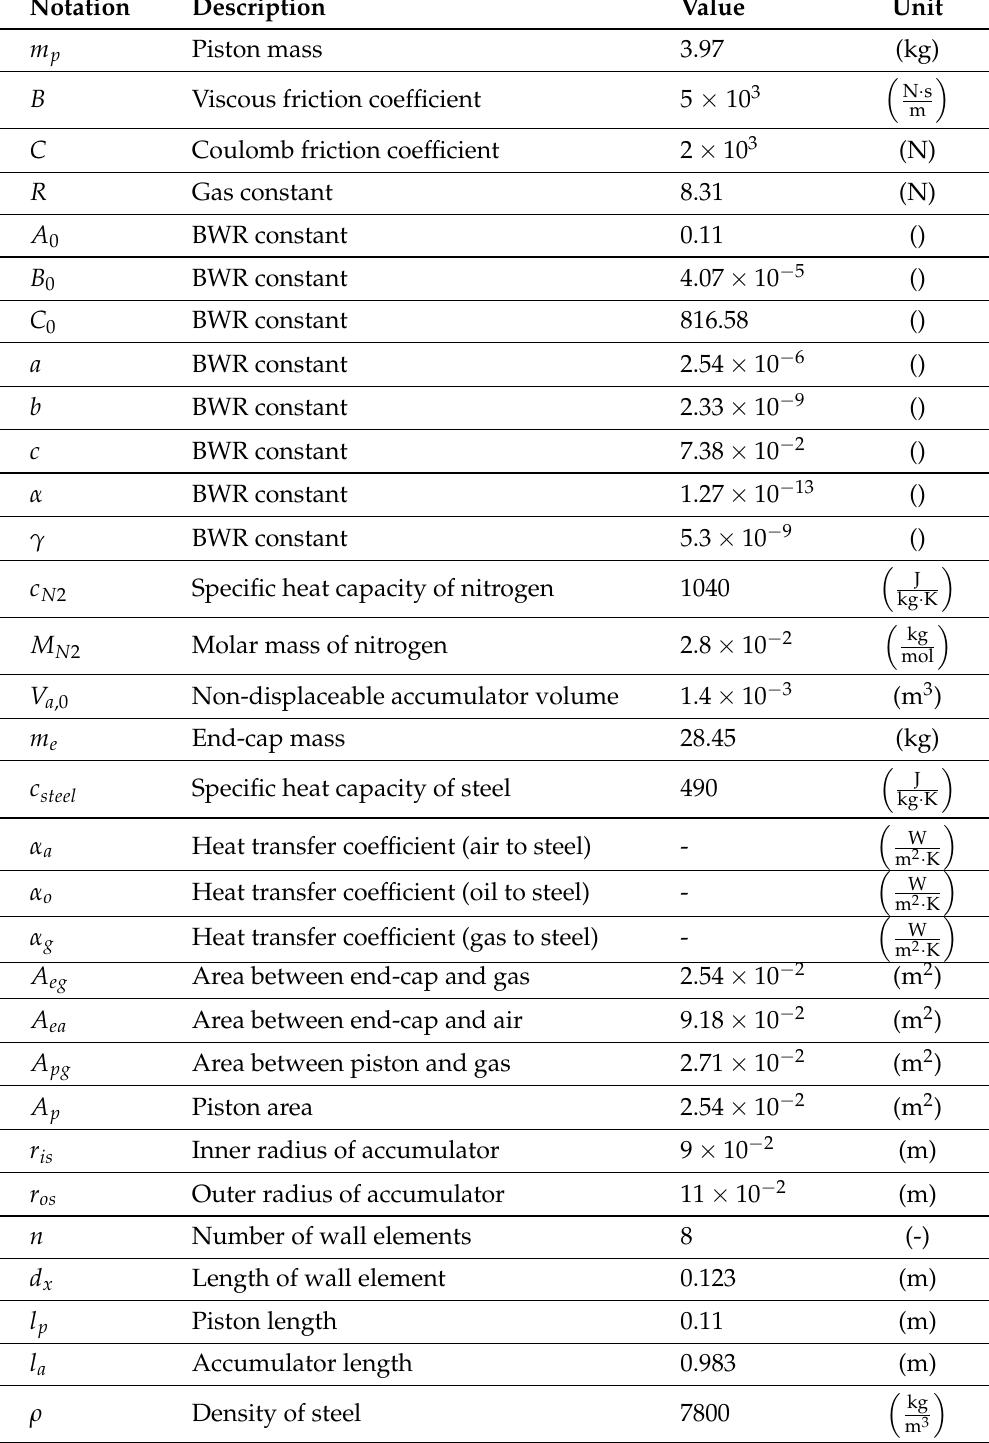
Table 1. Parameter values used in the model. The values for τ , α a , α o , and α g are not stated, but left as tuning parameters and evaluated during model validation